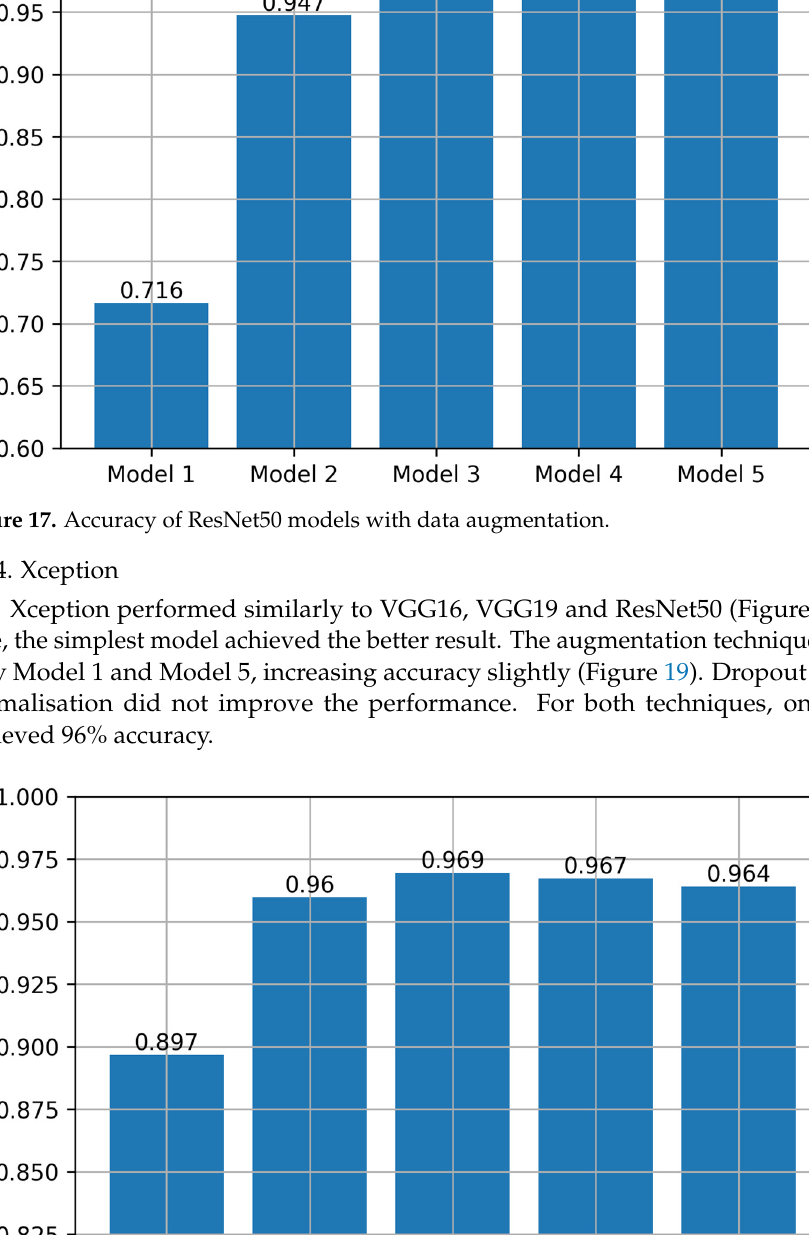
17 of 23 Figure 16. Accuracy of ResNet50 models.